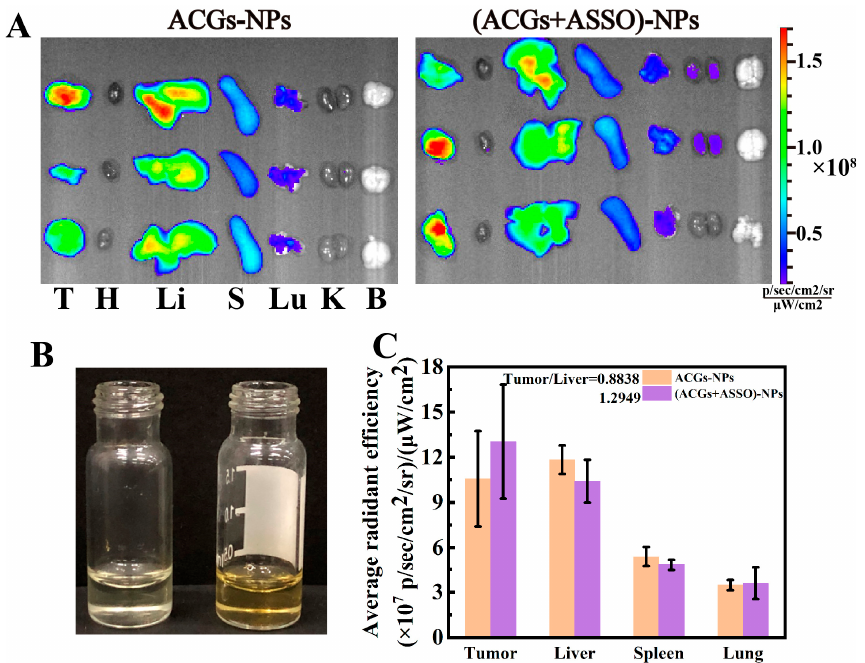
Figure 7. The difference of in vivo biodistribution of ACGs delivered alone and co-delivered with ASSO in 4T1 tumor-bearing mice. ( A ) Biodistribution of ACGs-NPs and (ACGs + ASSO)-NPs in isolated organs 48 h after administration, T: tumor, H: heart, Li: liver, S: spleen, Lu: lung, K: kidney, B: brain. ( B ) Appearance of ASSO without (left) and with ACGs (right). ( C ) Fluorescence intensity in different organs was presented. Data represent mean ± SD ( n = 3).